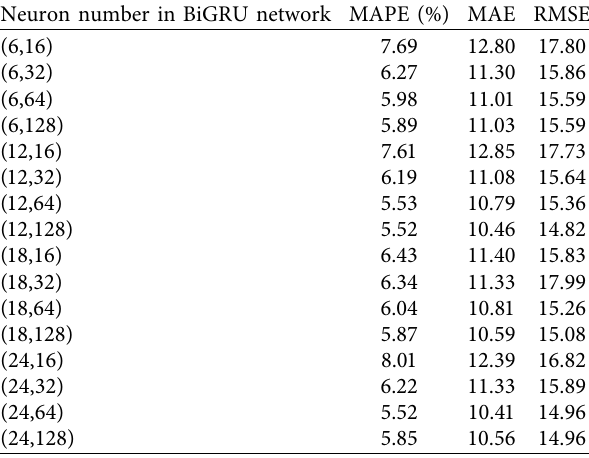
Table 2: Evaluation indicator results under different neuron numbers of BiGRU network.